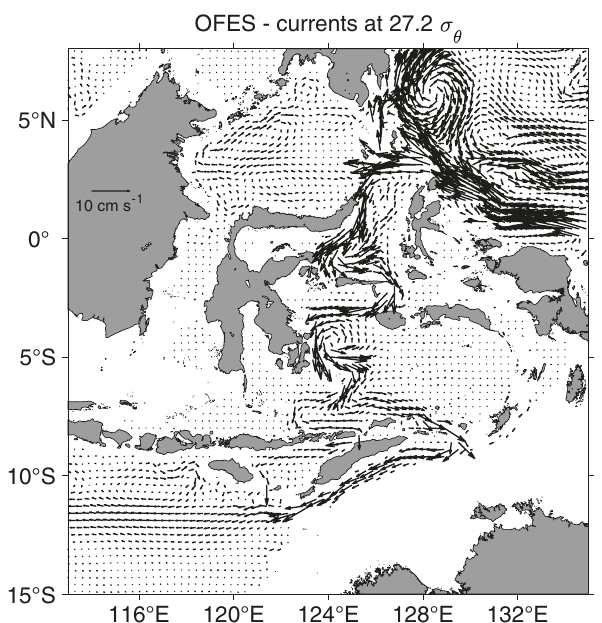
Fig. 5 Intermediate through fl ow in the OFES. Distributions of mean currents on the 27.2 σ θ isopycnal layer, based on the OFES model simulation during 2000 – 2018, showing the Maluku WBC originating from the NGCUC in the western equatorial Paci fi c Ocean. The NGCUC and WBC carries the subducted AAIW from the South Paci fi c Ocean to the southeastern tropical Indian Ocean through the eastern Indonesian